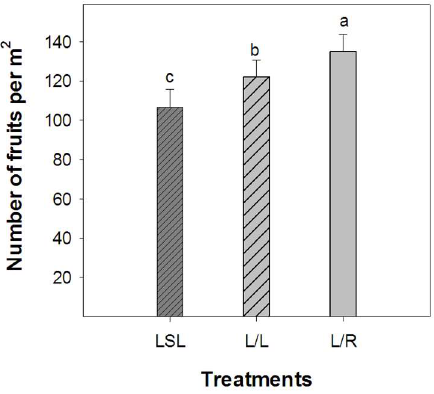
Figure 4. Number of fruits per m 2 produced by plants from the treatments LSL (long-shelf-life tomato), L/L (self-grafted Old Limachino tomato) and L/R (grafted Old Limachino tomato on Poncho Negro rootstock) under greenhouse conditions. Each value represents the mean ± SE ( n = 12). Lower-case letters indicate differences ( p ≤ 0.05, Duncan test) among treatments.